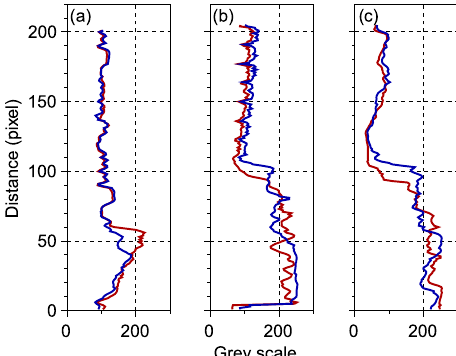
Figure 8. The boulder gauging station profile. The dashed lines rep- resent the water surface. Water is located below those lines. Panel (a) indicates the grey-scale profile and (b) the gradient of the pro- file; the calculation step is 2 pixels. The gradient plot makes the inflection point and the water level detection